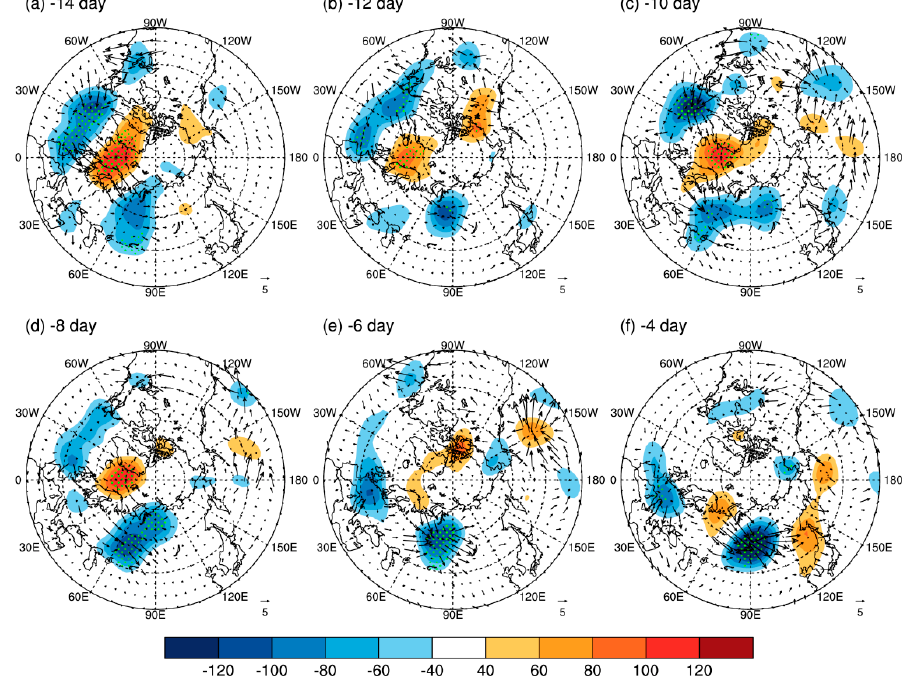
Figure 10. Same as Figure 9, but for the northwest type ( a–f ).